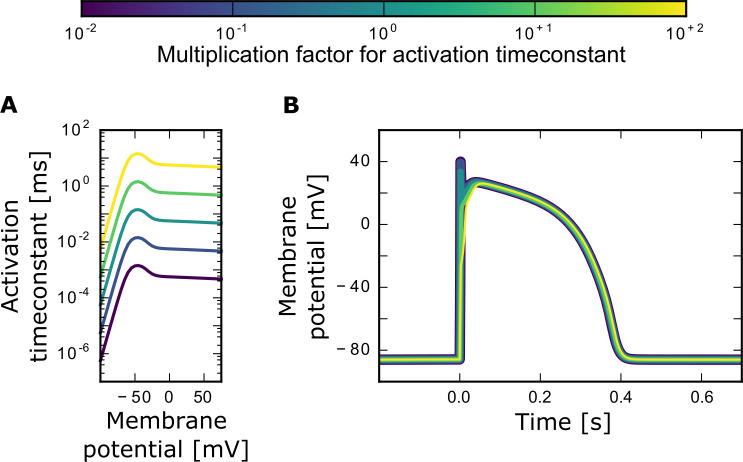
Changing the sodium channel activation time-constant τm.(A) Different multiplication factors (from 10−2 to 10+2) result in different activation time-constants. (B) Different activation time-constants lead to different shapes of the cardiac action potential. The colors match the corresponding activation curve in A. The plot shows one action potential triggered by a 2 ms stimulation pulse of 60 pA/pF amplitude. The system was given 1 s to settle onto the resting potential before the pulse started at timepoint zero.